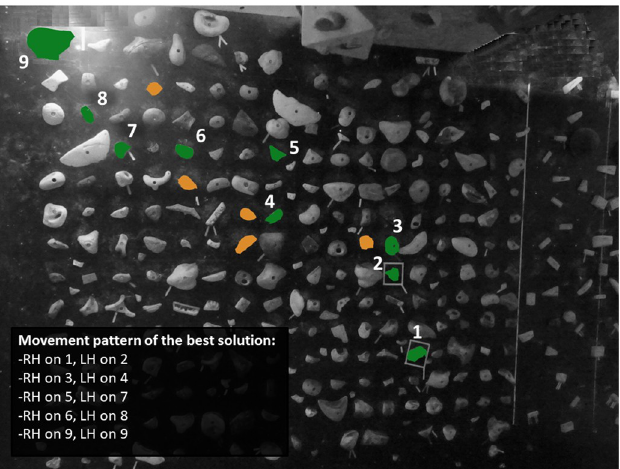
Fig 4. The bouldering task in Experiment 3 (RH: Right hand; LH: Left hand). The task was set with many climbing holds varying in size, shape, and colour. Experts marked the two handholds of the starting position (RH on handhold number 1 and LH on handhold number 2) and the last hold (handhold number 9). Between these marked handholds, participants were free to integrate any handholds into their ascent-tactics. The handholds of the experts’ best solution are marked in green colour and key grips (i.e., not part of the best solution but unchallenging to grasp and thus considered as valid alternative ascent-tactic) in orange colour.